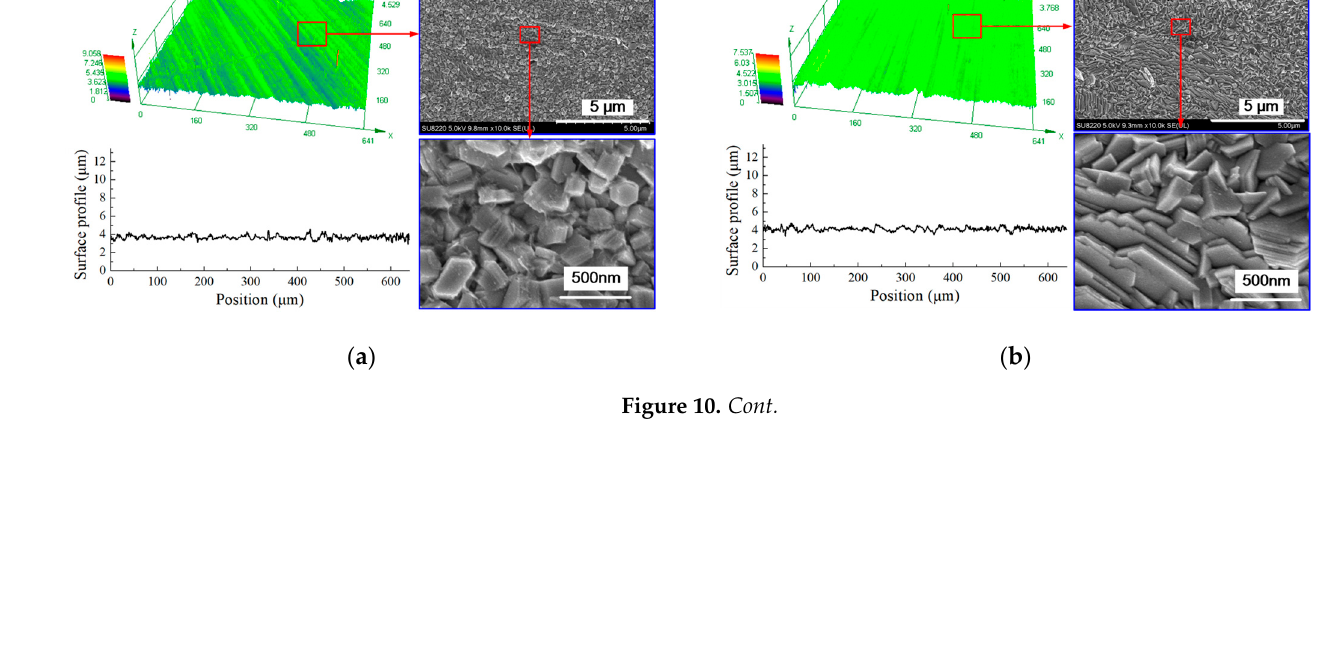
( e ) Figure 10. The surface morphology of the deposited coating at different current densities. ( a ) i = 0.125 A/dm 2 ; ( b ) i = 0.25 A/dm 2 ; ( c ) i = 0.375 A/dm 2 ; ( d ) i = 0.5 A/dm 2 ; ( e ) i = 0.625 A/dm 2 .